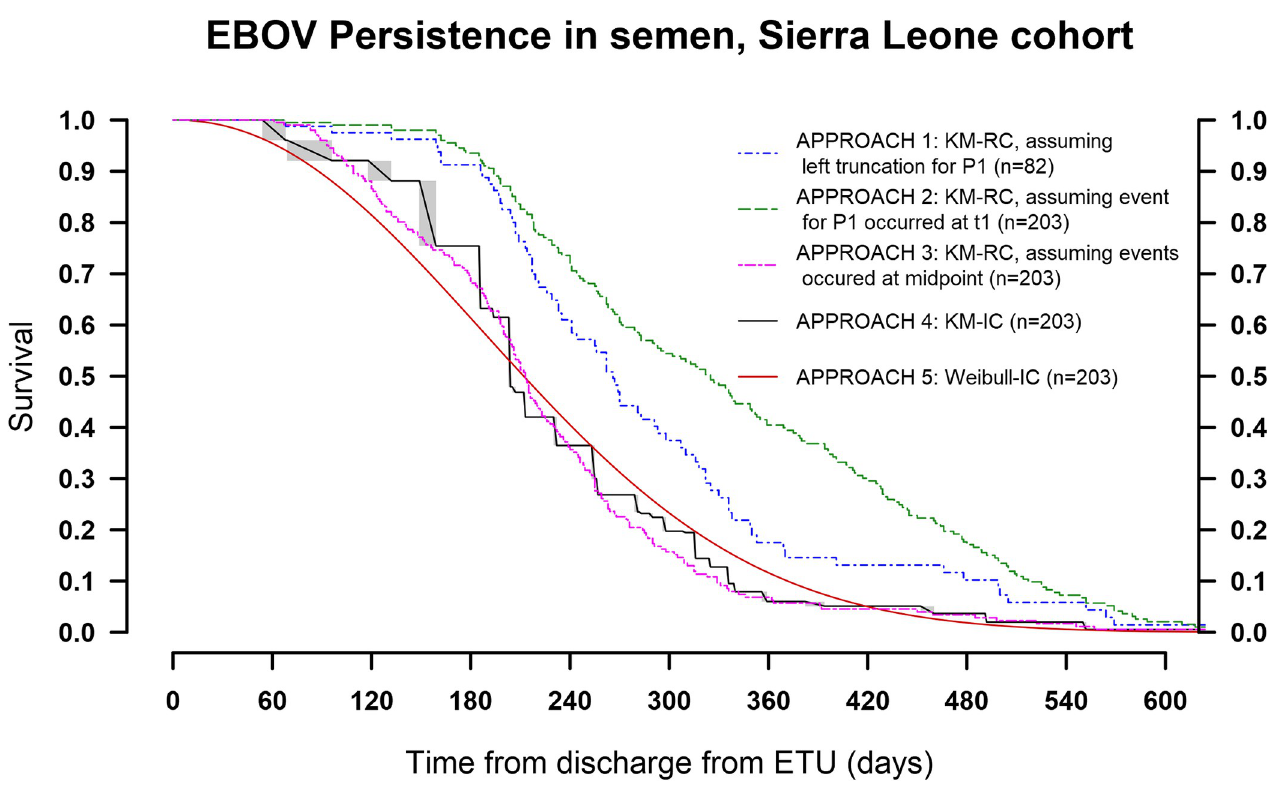
Fig 2. EBOV persistence using right- and interval censored non-parametric and parametric approaches.